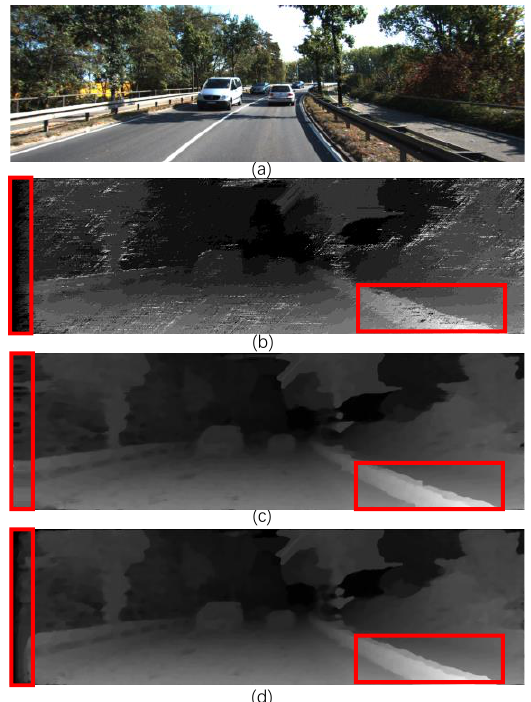
Figure 14. ( a ) No.110; ( b )No.128; ( c ) Grayscale disparity of ( a ); ( d ) Grayscale disparity of ( b ); ( e ) Pseudo-color disparity of ( a ); ( f ) Pseudo-color disparity of ( b ); ( g ) Error of ( a ) (noc:2.77%, occ:4.48%); ( h ) Error of ( b ) (noc:3.80%, occ:6.06%).